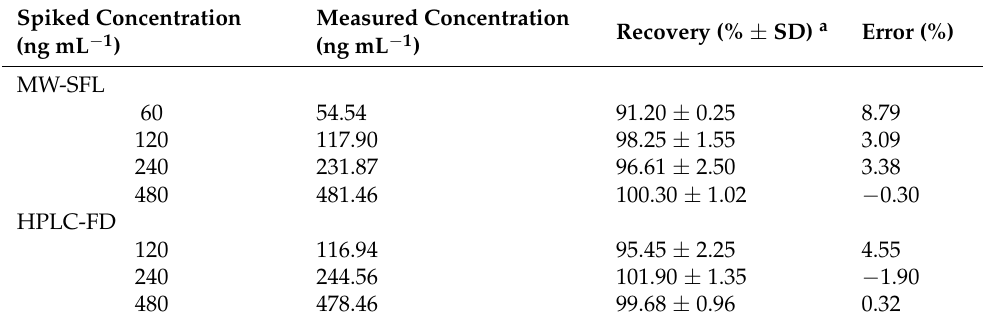
Table 5. The analysis of ALC in the spiked human urine samples by the proposed MW-SFL and HPLC-FD methods.